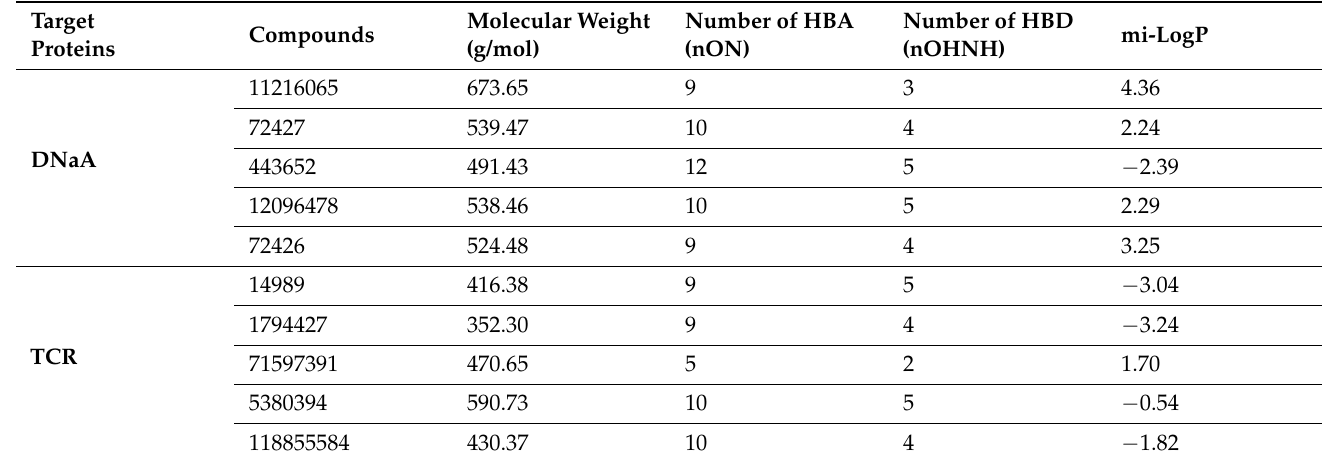
Table 4. Druglike characteristics of top